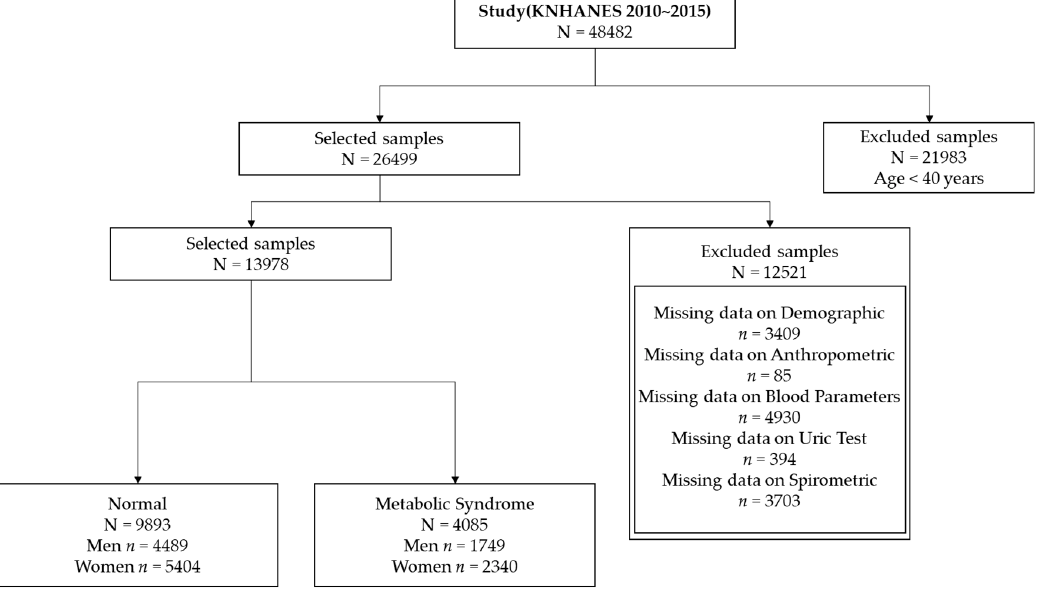
Figure 2. Sample selection procedure for association analysis.